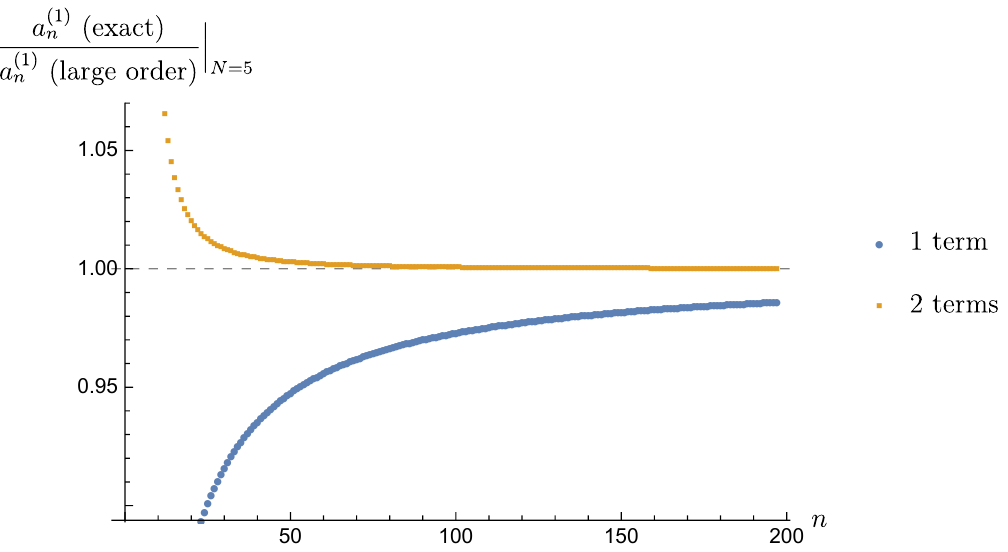
Figure 2 . Ratio of numerically computed large order growth of the perturbative coe(cid:14)cients a (1) n and the series expansion (2.17) with just the (cid:12)rst term (blue circles) and (cid:12)rst two terms (red